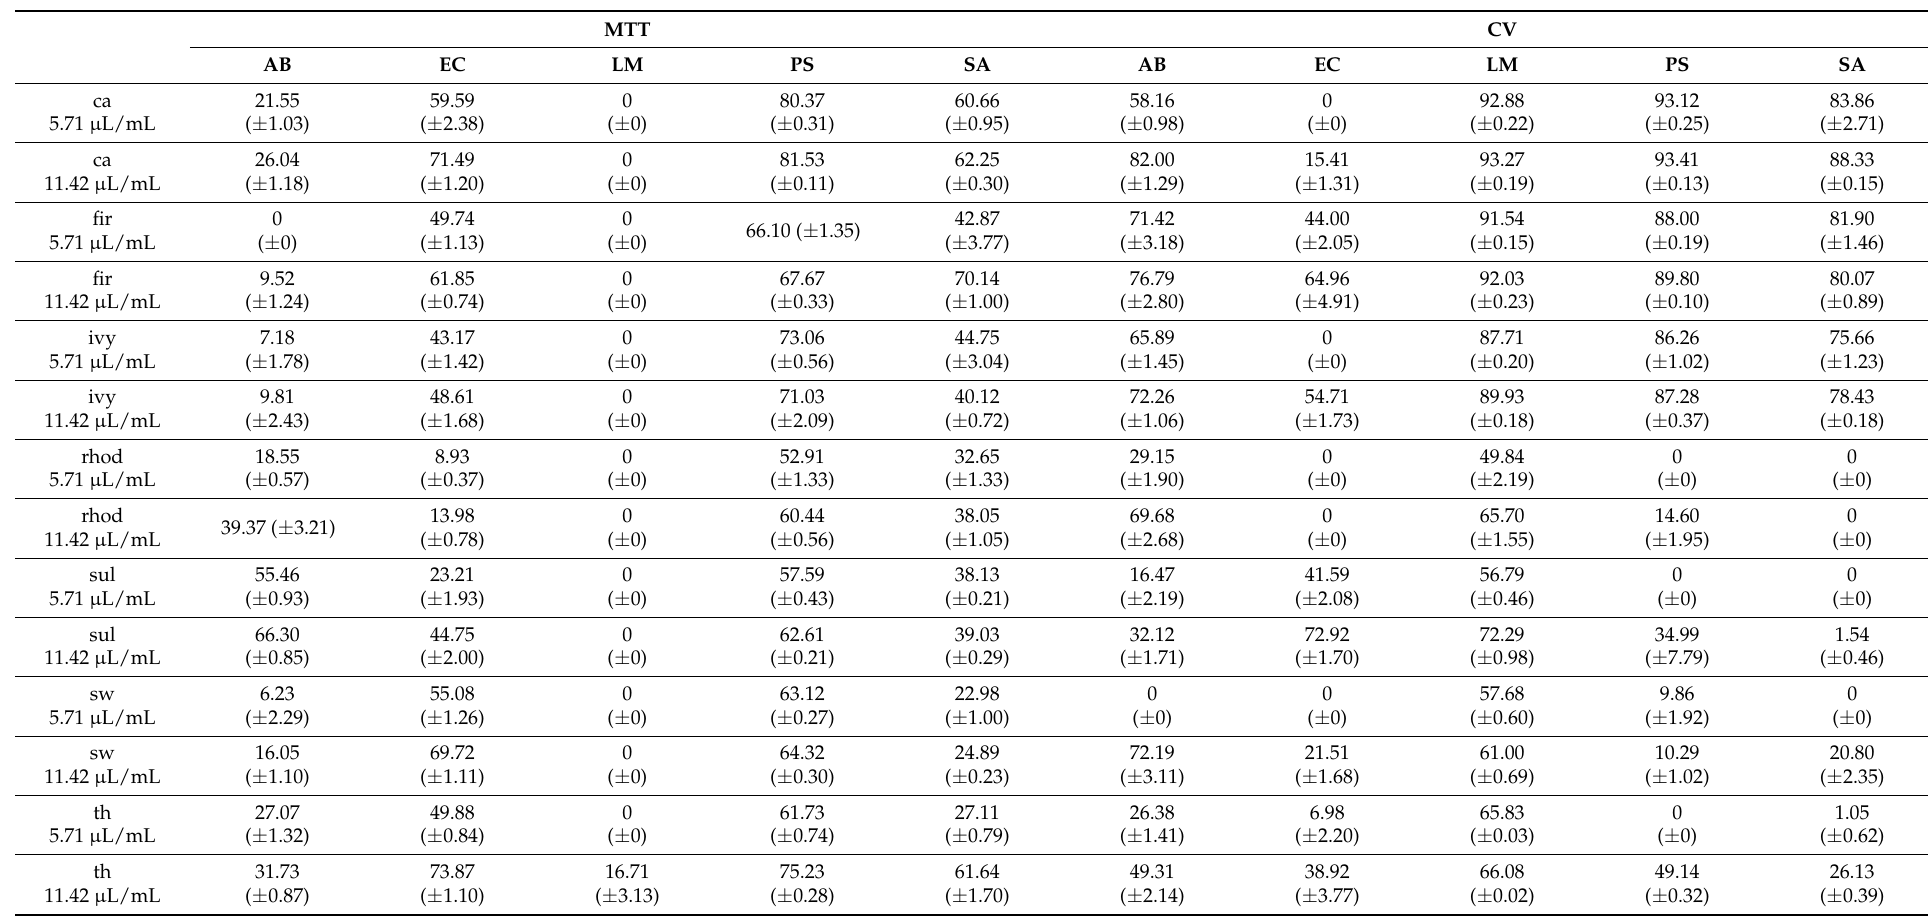
Table 3. Inhibitory activity of the monofloral honeys, tested at 5.71 µ L/mL and 11.42 µ L/mL, on the biofilm formation capacity by five pathogenic strains. Results are expressed as percentage (average ± SD) and calculated assuming for the control (untreated bacteria) an inhibition value = zero. Legend: ca: cardoon honey; fir: fir honey; ivy: ivy honey; rhod: rhododendron honey; sul: sulla honey; sw: strawberry tree honey; th: tree of heaven honey. AB: A. baumannii ; EC: E. coli ; LM: L. monocytogenes ; PS: P. aeruginosa ; SA: S. aureus. MTT: data of the inhibitory action exhibited by the honey on bacterial metabolism, evaluated through the MTT test; CV: data of the inhibitory action exhibited by the honeys on the biofilm, evaluated through the Cristal violet